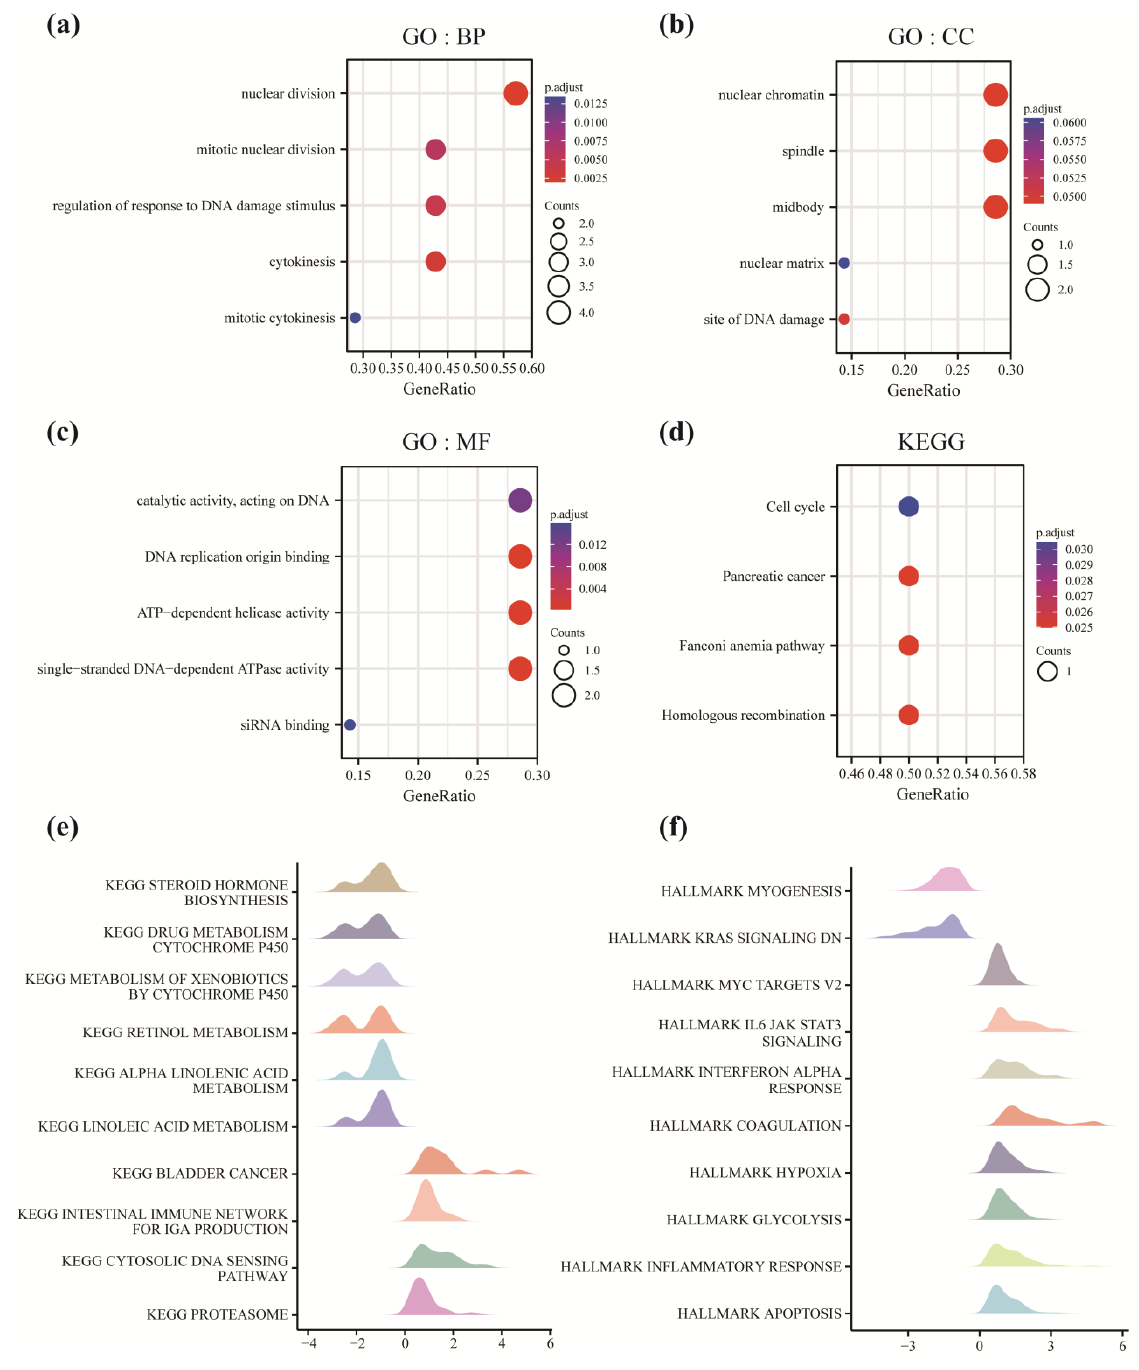
Figure 4. GO, KEGG, and GSEA. ( a – c ) Gene ontology (GO) enrichment analysis terms include Biological Process (BP), Cellular Component (CC), and Molecular Function (MF). The abscissa is the gene ratio, and the ordinate is the GO terms. The node size indicates the number of genes enriched, and the node color indicates − log10 ( p -value). ( d ) For the Kyoto Encyclopedia of Genes and Genomes (KEGG) pathway enrichment analysis, the abscissa is the gene ratio, and the ordinate is the pathway name. The node size indicates the number of genes enriched in the pathway, and the node color indicates −log10 ( p -value). ( e ) Gene-set enrichment analysis (GSEA) for OL and OSCC. The results are visualized in the form of mountain maps. The abscissa is the gene ratio, and the ordinate is KEGG. The color indicates the p -value. ( f ) GSEA for OL and OSCC samples. The results are visualized in the form of mountain maps. The abscissa is the gene ratio, and the ordinate is HALLMARK. The color indicates the p -value.